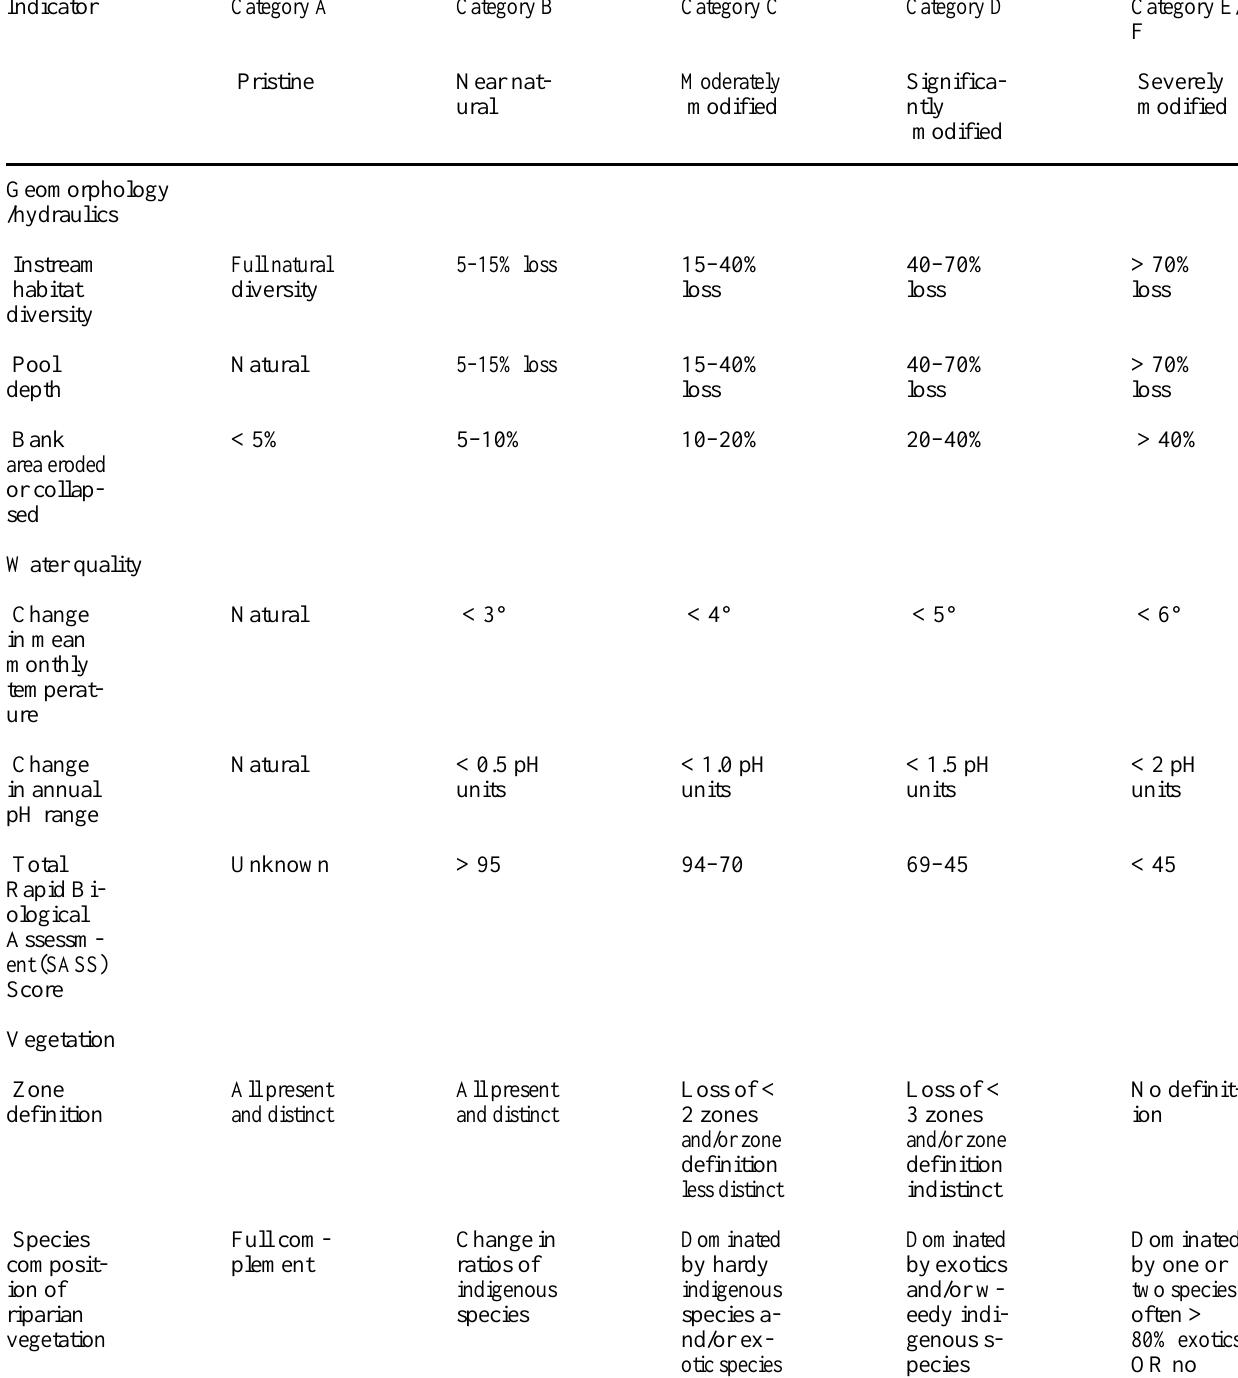
Table 11 . Template for an environmental flow monitoring program designed for the Lesotho Highlands Water Project (modified from LHDA 2003). The zones include the aquatic, lower wetbank, upper wetbank, lower dynamic, and tree/shrub zones (Metsi Consultants 2000 a